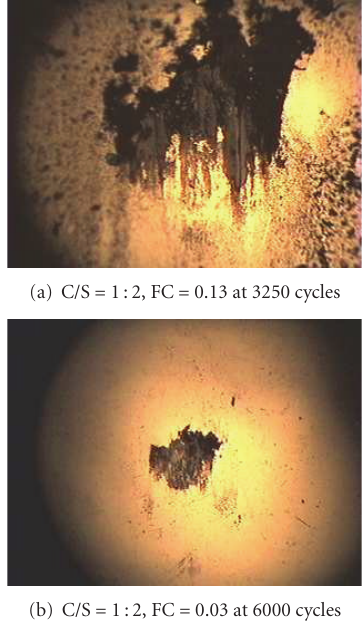
Figure 7: Wear scar micrographs on SUS440C balls under (a) ambient air, (b) high vacuum as bias voltage of 0kV. Table 4: Bond strengths in diatomic molecules